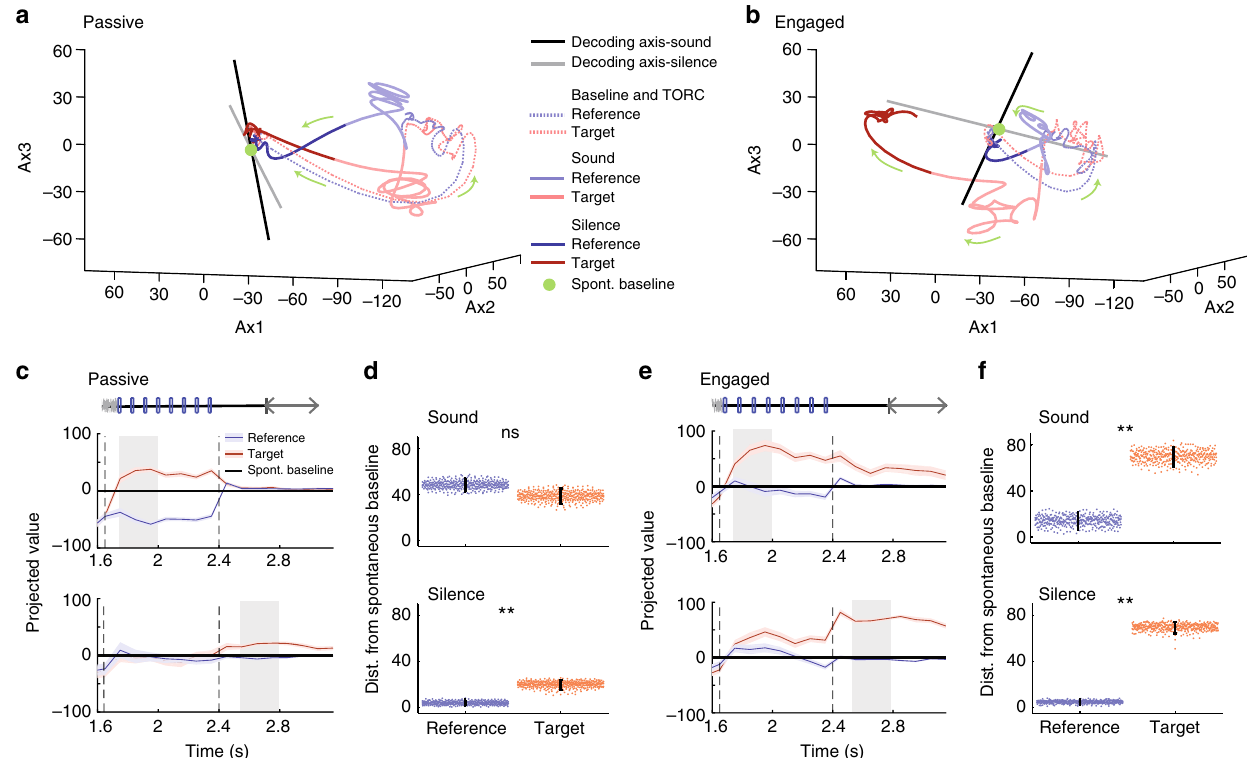
Fig. 3 Task engagement induces shift from symmetric to asymmetric representation of target and reference stimuli. a Population response during target and reference stimuli in the passive state along the fi rst three components identi fi ed using GPFA (see Methods) on single trial data. The session begins at the baseline (green dot), followed by the TORC presentation, (dotted line) then the click presentation of either the target and the reference sound (light red and blue, respectively) and fi nally the post-sound silence period (dark red and blue). Note in particular that, in the passive state, the reference and target activities move away symmetrically from the baseline point given by projection of spontaneous activity. b As in a , for the task-engaged state. Note that, in this state, target activity makes a much larger excursion from the baseline than reference activity. The axes are the same as in a , as the GPFA analysis was performed jointly on passive and engaged data. c Projection onto the decoding axis of trial-averaged reference- and target-evoked responses for the whole neural population. A baseline value computed from prestimulus spontaneous activity was subtracted for each unit, so that the origin corresponds to the projection of spontaneous activity (shown by black line). Decoding axes determined during sound presentation and post-stimulus silence are, respectively, used for projections in the top and bottom rows. The periods used to construct the decoding axis are shaded in gray. Error bars represent 1 std calculated using decoding vectors from cross-validation. This procedure allows for the visualization of the distance between reference- and target-evoked projections (that corresponds to decoding strength) and the distance of the stimuli-evoked responses from the baseline of spontaneous activity can be interpreted as the contribution of each stimulus to decoding accuracy. d Distance of reference and target projections from baseline in each condition during the sound and silence period. Error bars represent 95% con fi dence intervals ( n = 400 cross-validations; p = 0.15 and p < 0.0025; ** p < 0.01). e As in c for the engaged state. f As in d for the engaged state. ( n = 400 cross-validations; p < 0.0025 and p < 0.0025; ** p <